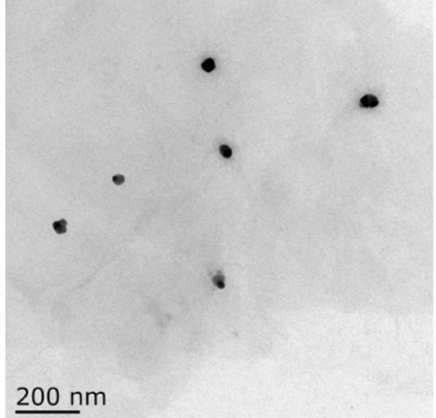
Figure 1. Size determination analysis of graphene oxide–silver nanoparticle (GO-AgNP) nanocompos- ites by transmission electron microscopy (TEM). The TEM image showed that the size of GO-AgNPs was about 20